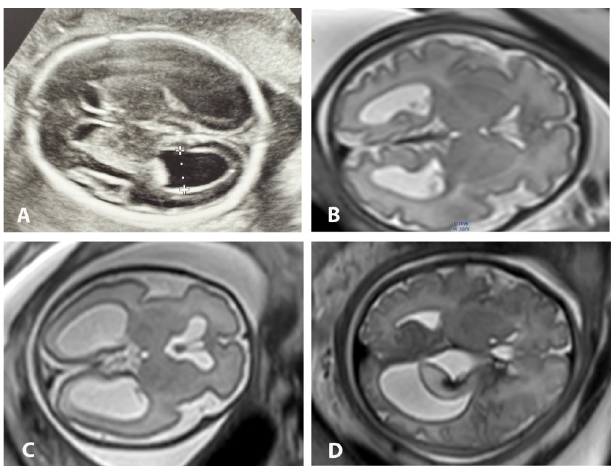
Figure 1. Axial US and MRI images of various degrees of ventriculomegaly. Ultrasonographic image at 28 GW with reverberation artifacts ( A ). Axial MR images of fetal brain with mild bilateral VM at 31 GW ( B ), moderate bilateral VM at 29 GW ( C ) and severe unilateral VM with choroid plexus pap- illoma hemorrhage ( D